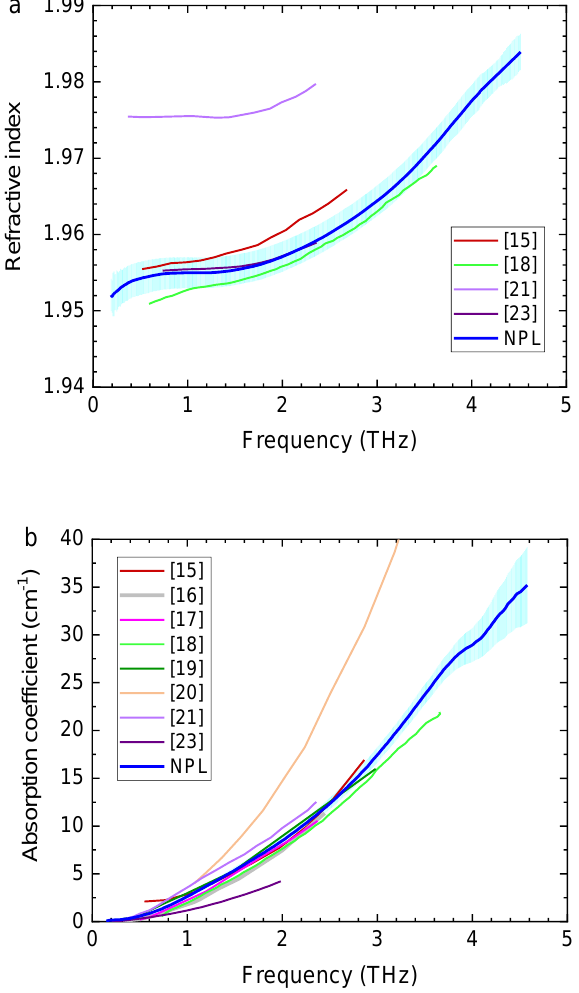
Figure 11. THz optical parameters of Spectrosil 2000 silica glass, shown as the mean (heavy blue line) and standard deviation (light blue shading) of the seven samples examined. Data reported in the literature are shown together with the results of this work. ( a ) refractive index; ( b ) absorption coefficient.